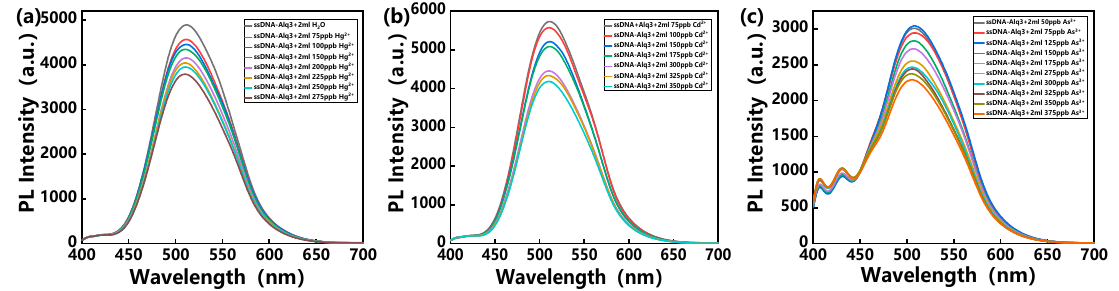
Figure 4. PL spectra of hybrid assemblies treated with MES buffer solution and exposed to various concentrations of ( a ) Hg 2+ , ( b ) Cd 2+ and ( c ) As 2+ solution, with excitation at 370 nm. Under the optimized conditions, the relationship between the PL intensities of dif- ferent hybrid assemblies and the concentration of corresponding target ions was investi- gated. The PL intensities showed a linear relationship with the level of the heavy metal ions in the range from 50 ppb to 350 ppb, as shown in Figure 5. Correlation coefficients (R 2 ) are 0.9945, 0.991, 0.9957 and 0.9917 for Pb 2+ , Hg 2+ , Cd 2+ and As 3+ , respectively. The limit of quantification (LOQ) is defined as 10S 0 /S, where S 0 is the standard deviation and S is the slope of the calibration curve [36]. According to this formula, the LOQs of Pb 2+ , Hg 2+ , Cd 2+ and As 3+ were calculated to be 22.92 ppb, 21.74 ppb, 12.68 ppb and 49.29 ppb, respec- tively.